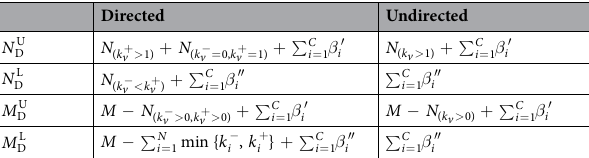
Table 1. Numbers of driver nodes and driven edges associated with upper and lower bounds. For general networks (directed or undirected), N DU and M DU are the numbers of driver nodes and driven edges associated with the upper bound, respectively. Similar notations hold for N DL and M DL . The upper and lower bounds are associated with unweighted and structural switching matrices, respectively. N and M are the number of nodes and the number of edges in network G , respectively, and + k and − k are the out- and in-degree, respectively. The v v is unity if the i th connected component only contains nodes quantity β ′ i